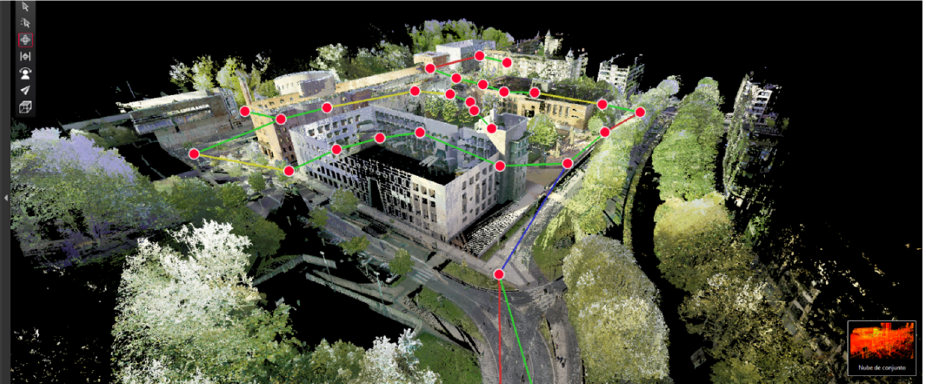
Figure 16. 3D point cloud. Review and optimization of scan of the UPV/EHU Campus, DSS, Zone 1. Description of the joints before the processing and optimization stage.